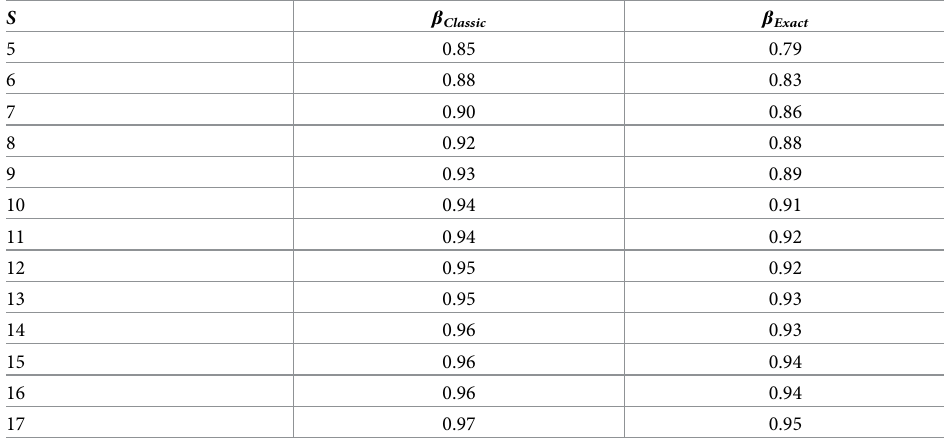
Table 3. Base-stock level computed by β Classic and β Exact with Poisson demand with λ = 1, s = 2, L = 2.